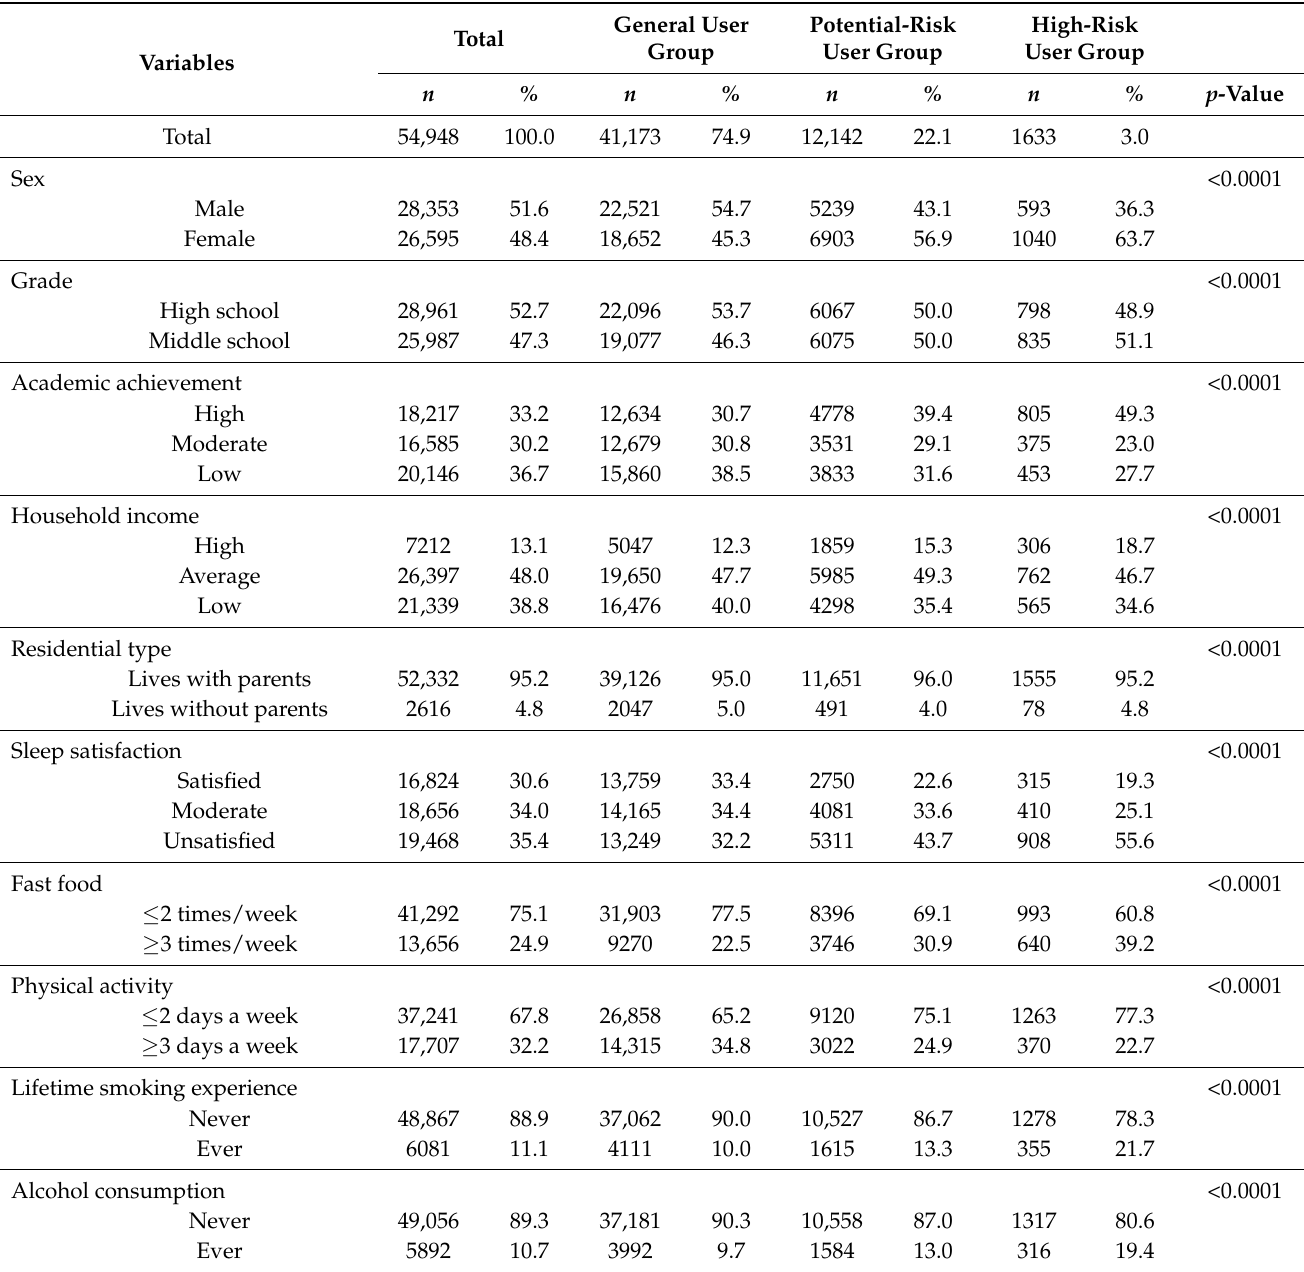
Table 1. General characteristics of the categorized smartphone use